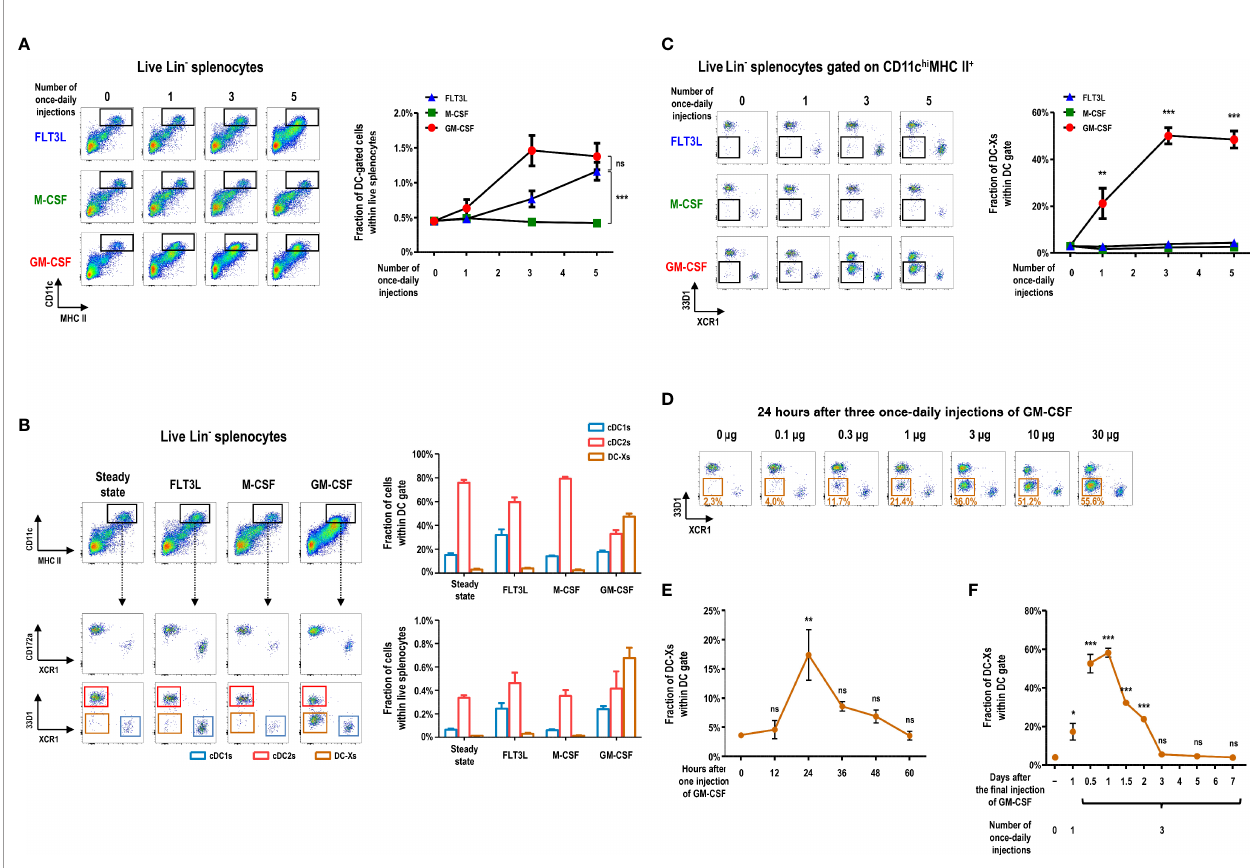
FIGURE 1 | GM-CSF treatment generates a new subset of DCs in the spleen. (A) Changes in lineage (Lin) - splenocytes within CD11c hi MHC II + DC gate are analyzed at 24 hours after different numbers of once-daily injections of 10 m g of the respective cytokines. Lin - cells exclude CD3 + , CD19 + , Ly6G + , and TER119 + cells. Data are shown in mean ± SEM (n = 3 to 7 mice for each condition). (B) Fractions of Lin - splenocyte subsets within DC gate at 24 hours after 3 once-daily injections of the respective cytokines. Data are shown in mean ± SEM (n = 7 mice for each condition). (C) Changes in the fraction of splenocytes within XCR1 - 33D1 - DC-X gate at 24 hours after different numbers of once-daily injections of the respective cytokines. Data are shown in mean ± SEM (n = 3 to 7 mice for each condition). (D) Fraction of splenic DC-Xs within DC gate at 24 hours after 3 once-daily injections of graded doses of GM-CSF. Representative fl ow cytograms (n = 2 mice for each condition). (E, F) Kinetic changes of splenic DC-Xs after 1 injection (E) and 3 once-daily injections (F) of 10 m g of GM-CSF. Data are shown in mean ± SEM (n = 3 mice for each condition). * p ≤ 0.05; ** p ≤ 0.01; *** p ≤ 0.001; ns, not signi fi cant; one-way (E, F) or two-way (A, C) ANOVA